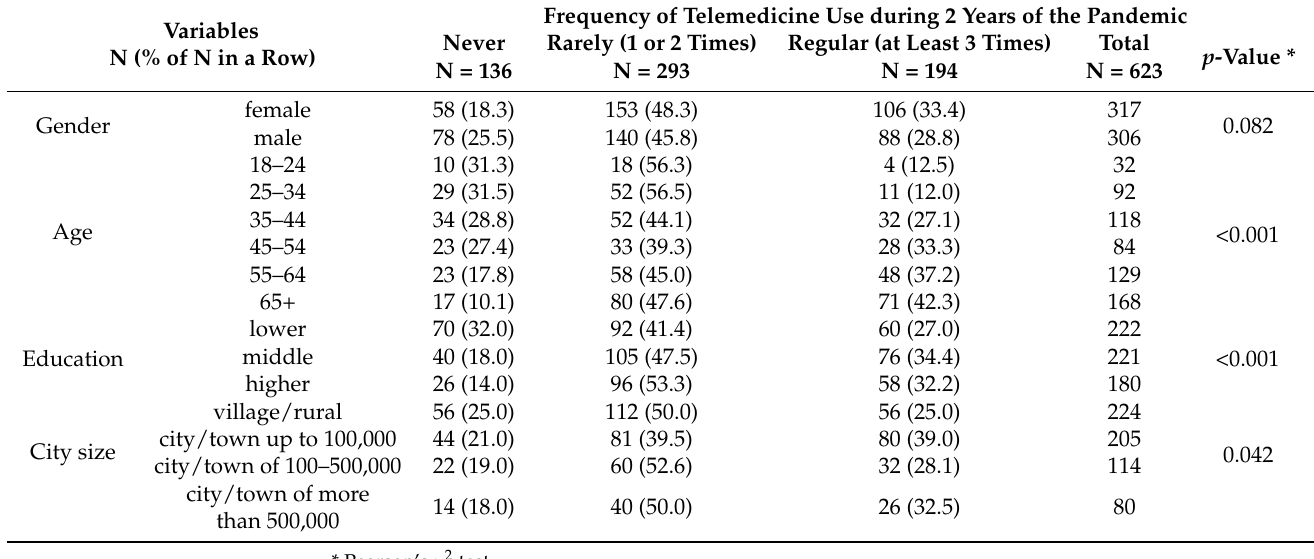
Table 1. Characteristics of the study population.